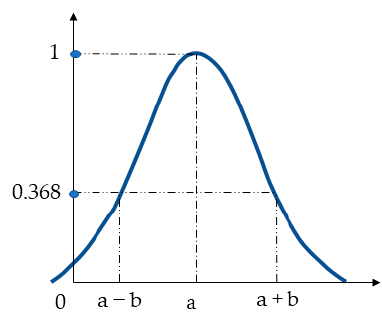
Figure 3. The shape of the MF (Gaussian FN).